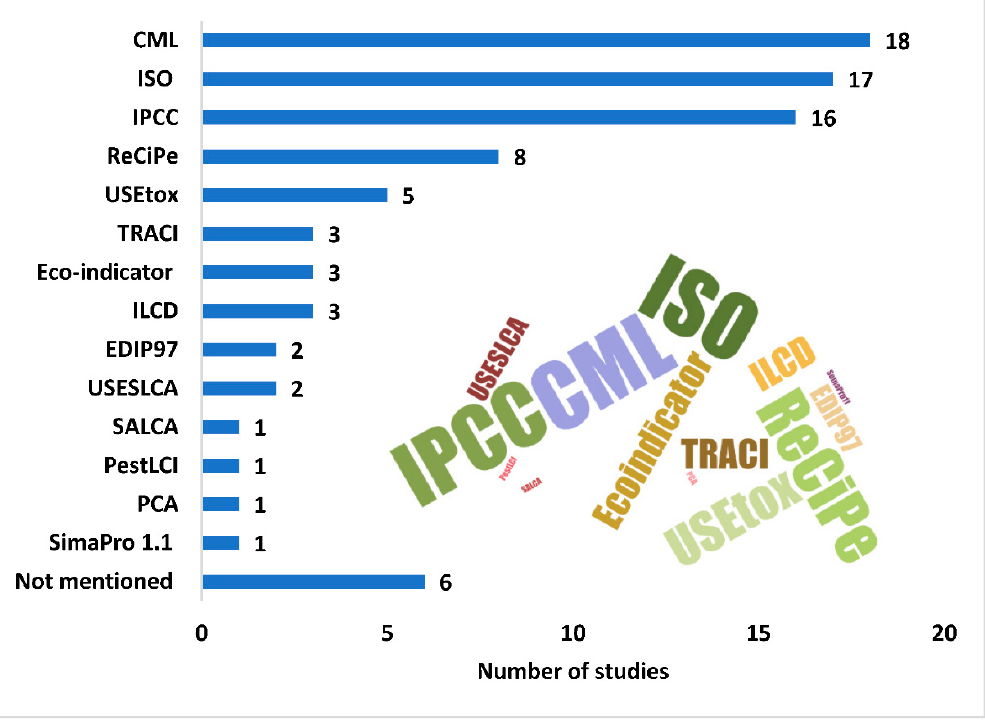
Figure 15. LCIA methods obtained from the literature review denoted by means of bar plots and a world cloud (classification).